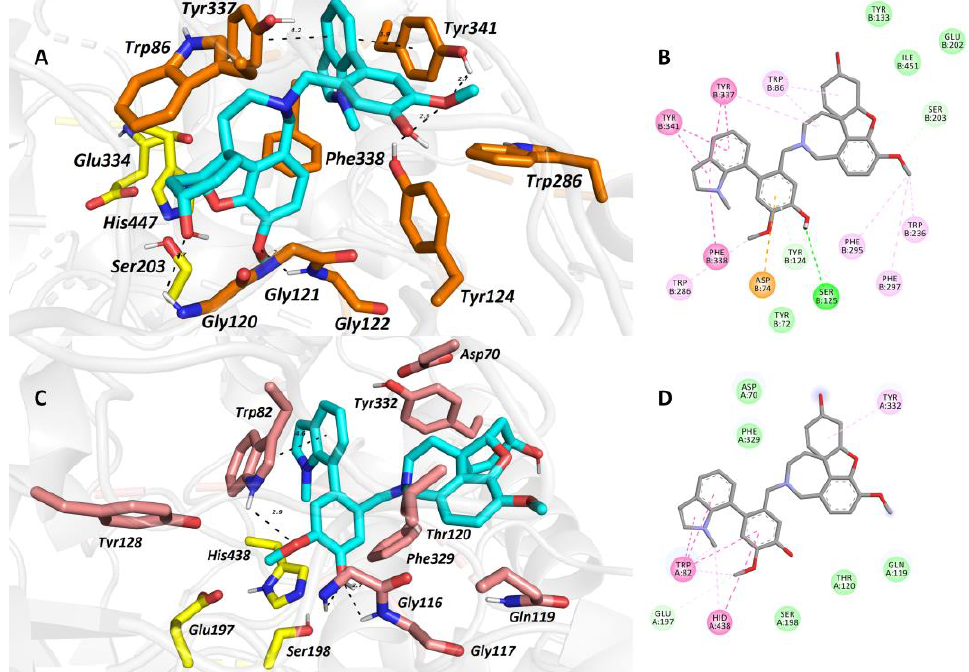
Figure 5. The top-scored docking poses of 2 in the h AChE ( A , B ; PDB ID: 4EY6) and h BuChE ( C , D ; PDB ID: 4BDS) active sites. Spatial orientation for each ligand is presented as three-dimensional ( A , C ) and two-dimensional ( B , D ) diagrams, respectively. The ligand is displayed in light blue ( A , C ); important amino-acid residues responsible for ligand anchoring are shown in orange for h AChE and salmon for h BuChE. Catalytic triad residues are displayed in yellow ( A , C ). Important interactions are rendered with black dashed lines; distances are measured in angstroms (Å). The rest of the receptor is displayed in light-gray cartoon conformation ( A , C ). Panels ( A ) and ( C ) were created with the PyMOL Molecular Graphics System, Version 2.4.1, Schrödinger, LLC. Two-dimensional (2D) diagrams ( B , D ) were created with Dassault Syst è mes 2016, BIOVIA, Discovery Studio Visualizer, v 17.2.0.16349, San Diego, CA, USA.